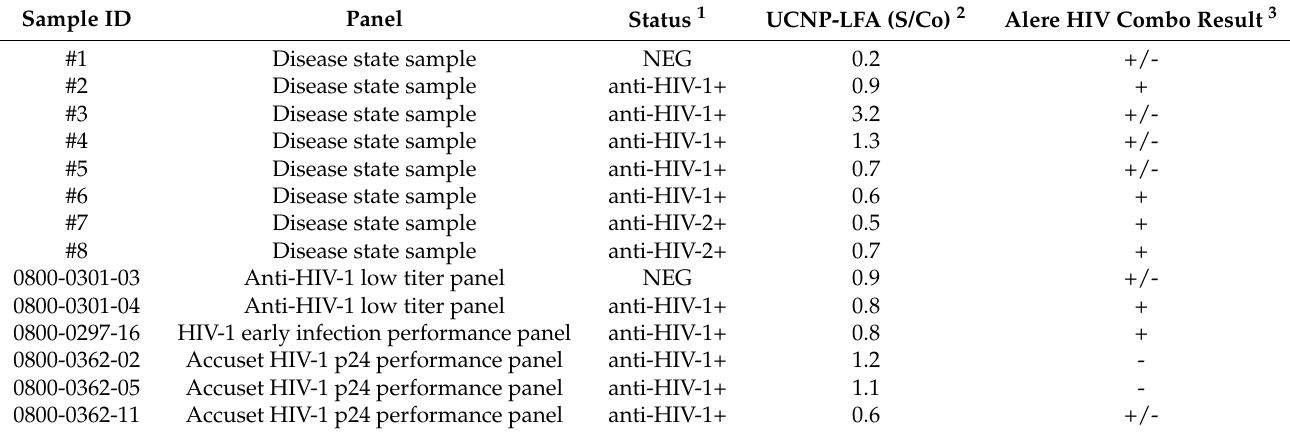
Table 4. Discrepant results between the Alere HIV Combo test and the developed Anti-HIV-1/2 UCNP-LFA. Sample